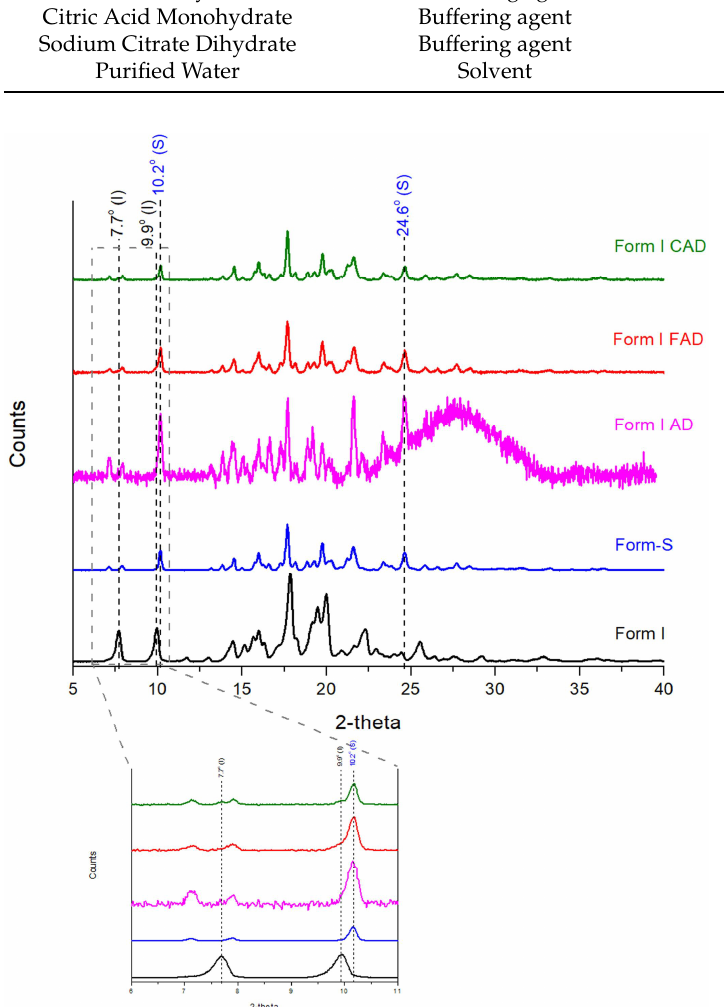
Figure 1. XRPD patterns of Poscaonazole API Form I, posaconazole API Form-S, a posaconazole Form I aqueous dispersion (AD), a posaconazole Form I filtered aqueous dispersion (FAD) and a posaconazole Form I centrifuged aqueous dispersion (CAD) covered with a transparent LDPE cling film (black peak labels: characteristic peaks for posaconazole Form I; blue peak labels: char- acteristic peaks for posaconazole Form-S). In order to obtain a better S/N ratio for studying the transformation, a 40 mg/mL aqueous dispersion of posaconazole Form I was prepared by magnetic stirring at 500 rpm for 30 min. Subsequently, the water dispersion was either centrifuged at 8000 rpm, 25 °C for 23 min or filtered using vacuum. In this way, the majority of the excess water mole- cules were removed and the API was isolated. The XRPD patterns of the posaconazole API received by centrifugation or filtration of posaconazole Form I aqueous dispersion were recorded after being covered with LDPE cling film I order to avoid water evapora- tion and conversion back to Form I (Figure 1 Form I FAD and Form I CAD). The XRPD patterns were found to highly resemble the pattern of the aqueous dispersion (Figure 1